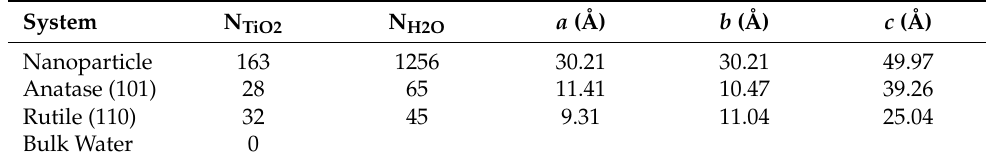
Table 1. Simulation cell parameters for the various systems. System